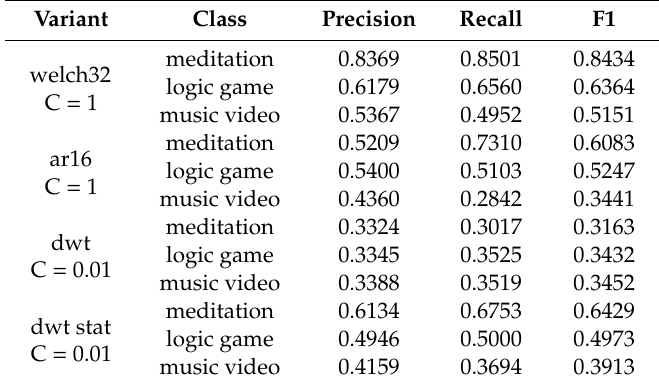
Table13. Valuesofprecision, recall,